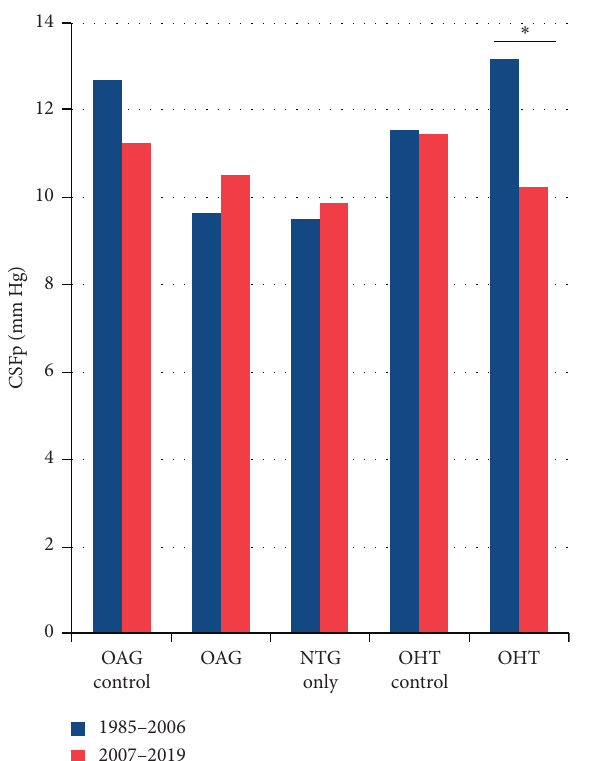
Figure 1: Validating the 2007–2019 data set against the 1985–2006 data set. There was no significant difference between the CSFp for OAG and OAG controls in the 2007–2019 data set ( p � 0 . 24 ) . The CSFp values were statistically similar between 1985–2006 and 2007–2019 data sets for the OAG and OAG control groups (1985–2006 OAG vs. 2007–2019 OAG, p � 0 . 29; 1985–2006 NTG vs. 2007–2019 NTG, p � 0 . 78). The CSFp value for OHTcases was significantly lower in the 2007–2019 data set than the 1985–2006